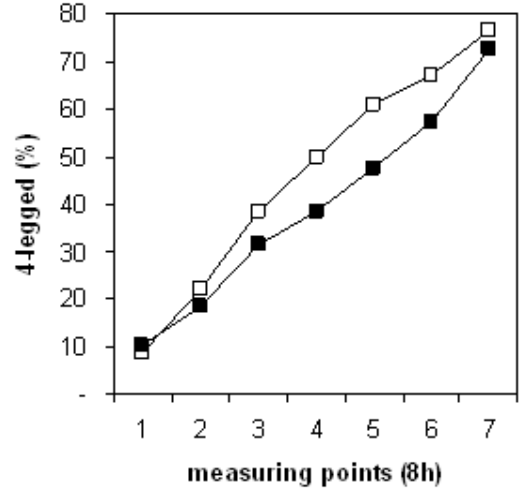
FIGURE 1. The effect of thyroxin 10 –11 – 10 –21 (“Q” dilutions 1, 2, and 3) on highland R. temporaria. Ordinate = cumulative frequency of four-legged tadpoles (N). Abscissa = points in time. Black squares = frequencies of animals treated with homeopathically prepared thyroxin; white squares = animals treated with analogously prepared water. For further details, see